Question: Write a caption explaining this figure to a reader.
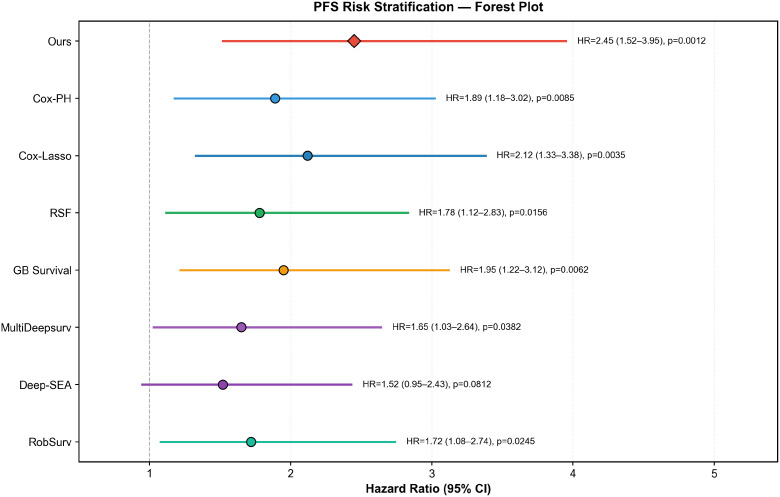
Answer: Forest plot of hazard ratios (95% CI) for progression-free survival across evaluated methods.